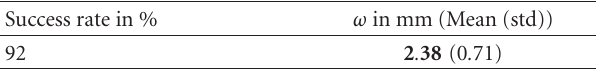
Table 4: Robustness study. Results of the proposed method for patient